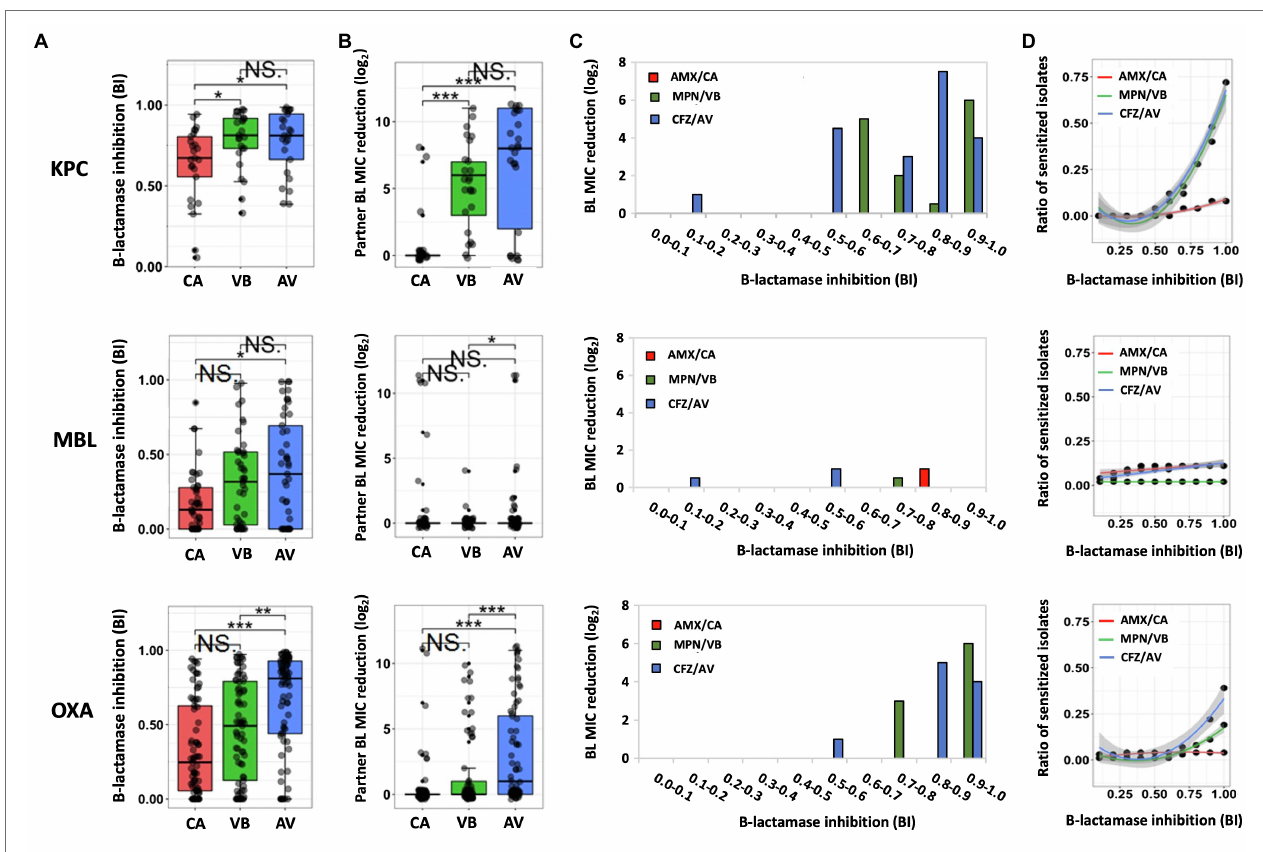
FIGURE 1 | Quantitative relationship between BLI’s β -lactamase inhibition and its partner BL’s susceptibility restoration in CPO human isolates. Distribution of β -lactamase inhibition (A) and the resulted partner BL susceptibility restoration (B) of three clinically representative BLIs (50 μ M) in CPO human isolates containing KPC carbapenemase, MBL carbapenemase, OXA carbapenemase. Partner BL MIC reduction on average (C) and the ratio of sensitized isolates (BL MIC reduction ≥ 4 times) (D) by the function of β -lactamase inhibition among different molecular groups of CPO human isolates. BI, β -lactamase inhibition index; NS., no significant difference; *, significant difference ( P value of <0.05); **, significant difference ( P value of <0.01); ***, significant difference ( P value of